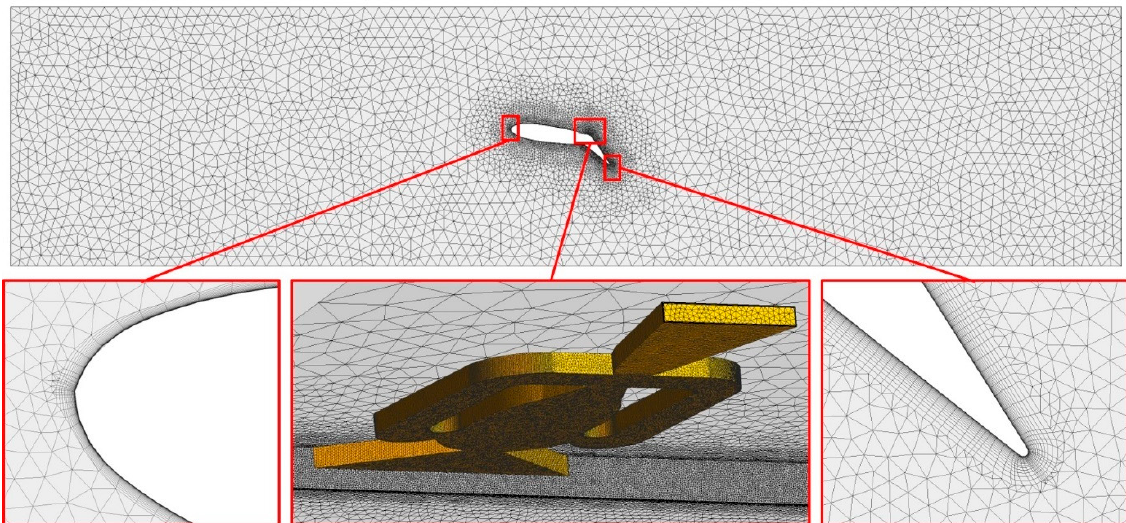
Figure 6. Grid system in internal and external domains ( α = 8° and δ f = 40°).